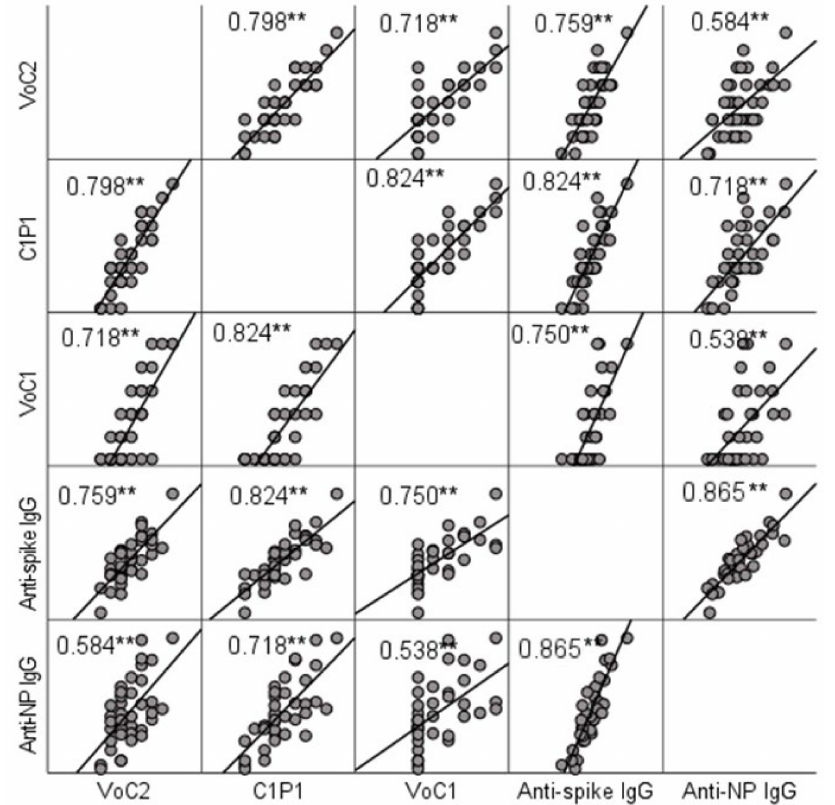
Figure 2. Correlation between NAb titers and IgG titers determined by ELISA testing. Scatter matrix comparing NAb titers with 3 virus strains and IgG titers with spike protein and nucleoprotein. Spearman’s rho-values between NAb titers with each virus strain and anti-spike and anti-NP IgGs are included in the picture, and significant values at level 0.01 (2-tailed) are marked with